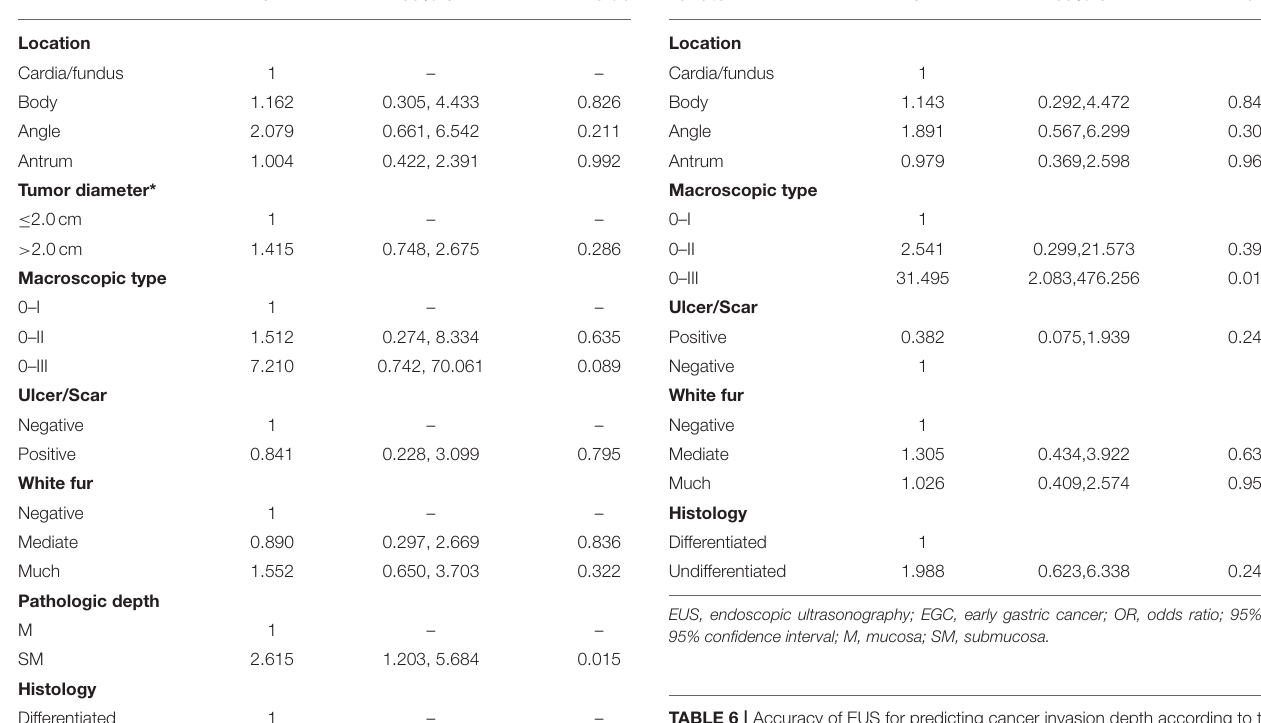
TABLE 5 | Multivariate analysis of risk factors for over-staging of EUS for diagnosing invasion depth of EGC. Variate OR